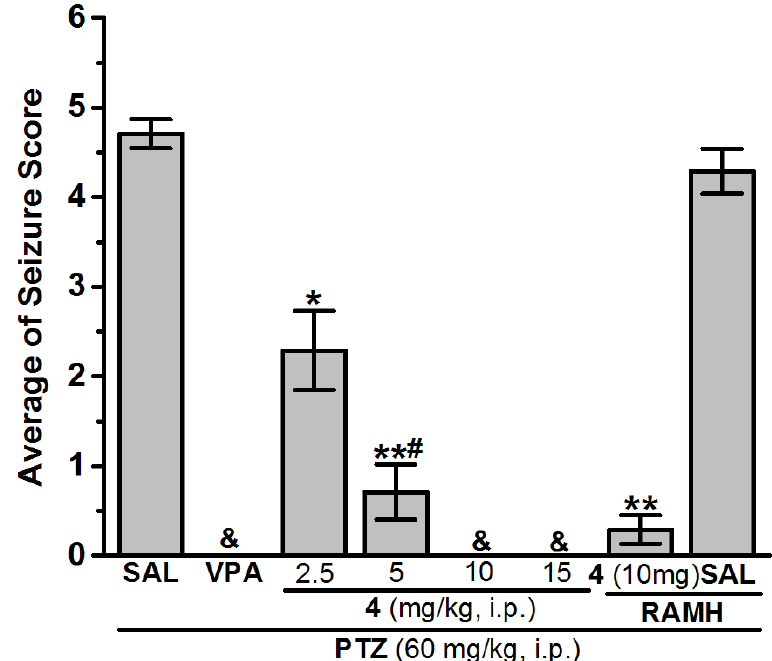
Figure 2. Anticonvulsant effect of H3R antagonist 4 pretreatment on pentylenetetrazole (PTZ)-induced convulsion in rats. Valproic acid (VPA, 300 mg/kg, i.p.) and test compound 4 (2.5, 5, 10, and 15 mg/kg, i.p.) were injected 30 – 45 min before PTZ (60 mg/kg, i.p.) treatments. Values are represented as the mean ± SEM ( n = 7). * p < 0.05 vs. (saline)-treated group. ** p < 0.001 vs. (saline)-treated group. # p < 0.05 vs. (2.5 mg)-treated group. & Full protection.